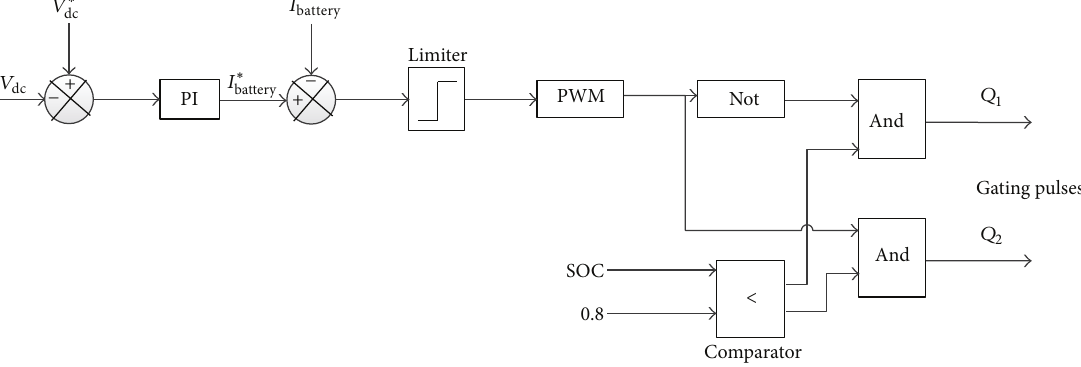
Figure 12: The schematic diagram of DC-DC converter